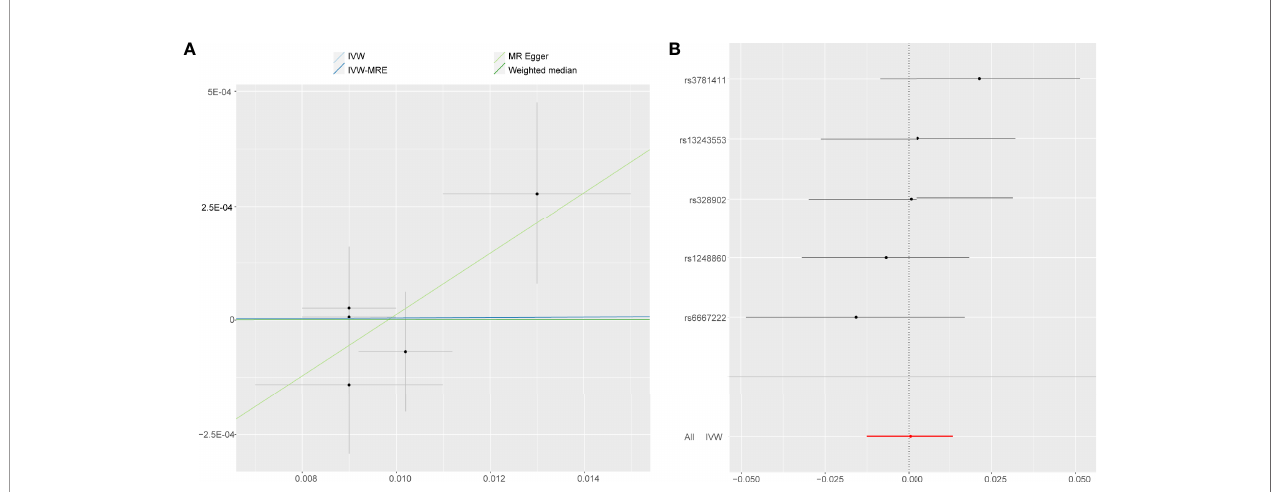
FIGURE 5 | Forest plot and scatter plot of the association of self-reported vigorous PA with the risk of AS. (A) Scatter plot: each black dot indicates a SNP, plotted by the estimate of SNP on self-reported vigorous PA and the estimate of SNP on the risk of AS with standard error bars. The slopes of the lines correspond to causal estimates using each of the different methods. (B) Forest plot: the dot and bar indicate the causal estimate of self-reported vigorous PA on risk of